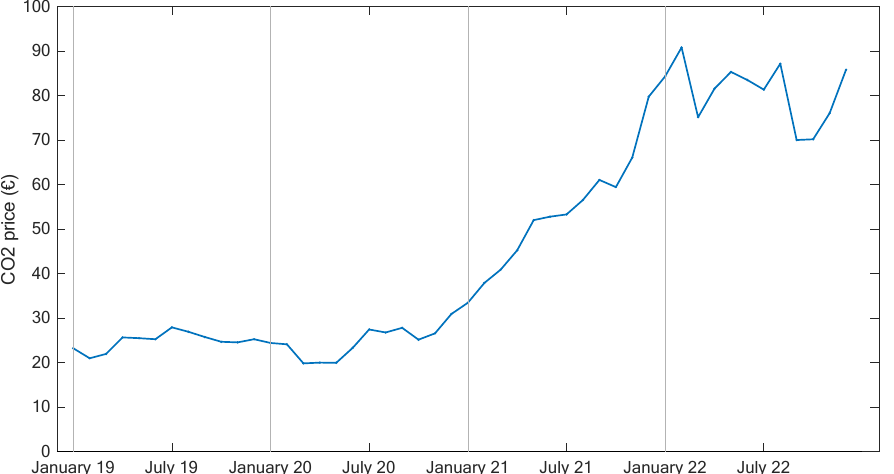
Figure 5. Average monthly prices of emissions allowances (EUA) traded on the European Union’s Emissions Trading System (euros per CO 2 ton).